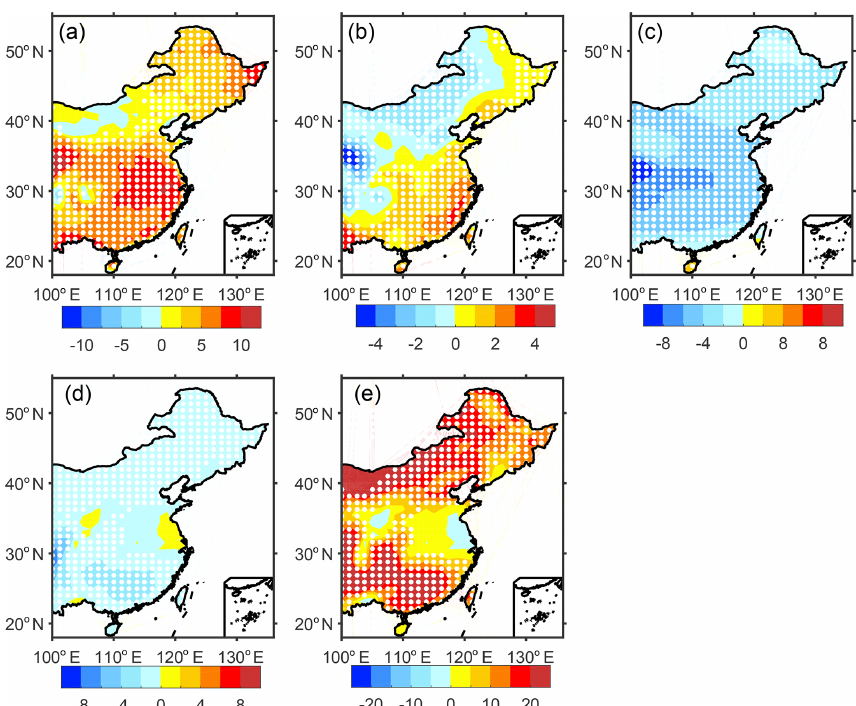
Figure 5. Simulated changes in weather conditions of the air pollution across eastern China due to the GHG-induced warming. (a) Changes in the planetary boundary layer height (PBLH) at the end of the 21st century compared to the years of 2006–2015 from the RCP8.5_FixAerosol2005 experiment. Panels (b) and (c) are similar to (a) but for the wind speed at near-surface and 500hPa levels, re- spectively. (d) Changes in the light precipitation days (daily accumulated precipitation < 10mm) at the end of the 21st century compared to the current state. Panel (e) is similar to (d) but for the heavy precipitation days ( > 10mm). Dots in the figure mean the changes are significant at the 95% confidence level using Student t test for all years and ensembles. Units: percentage